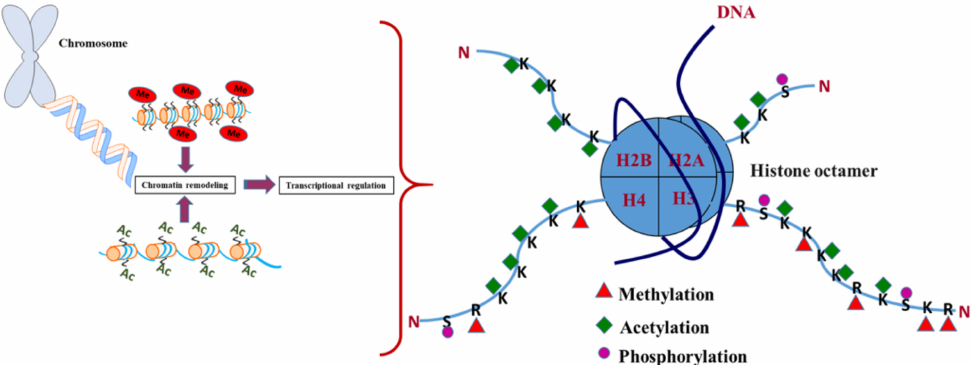
Figure 1. Major histone modifications associated with nucleosomal